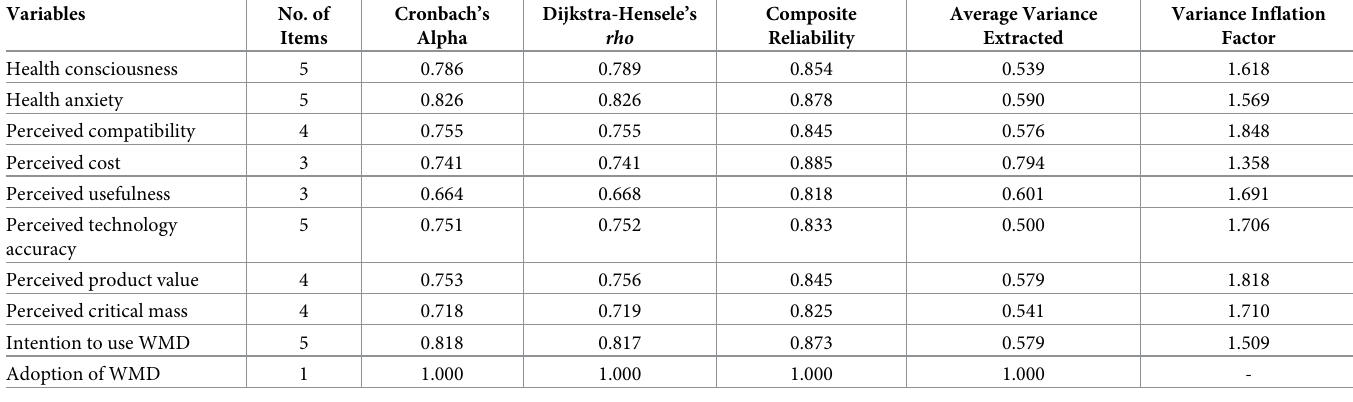
Table 2. Reliability and